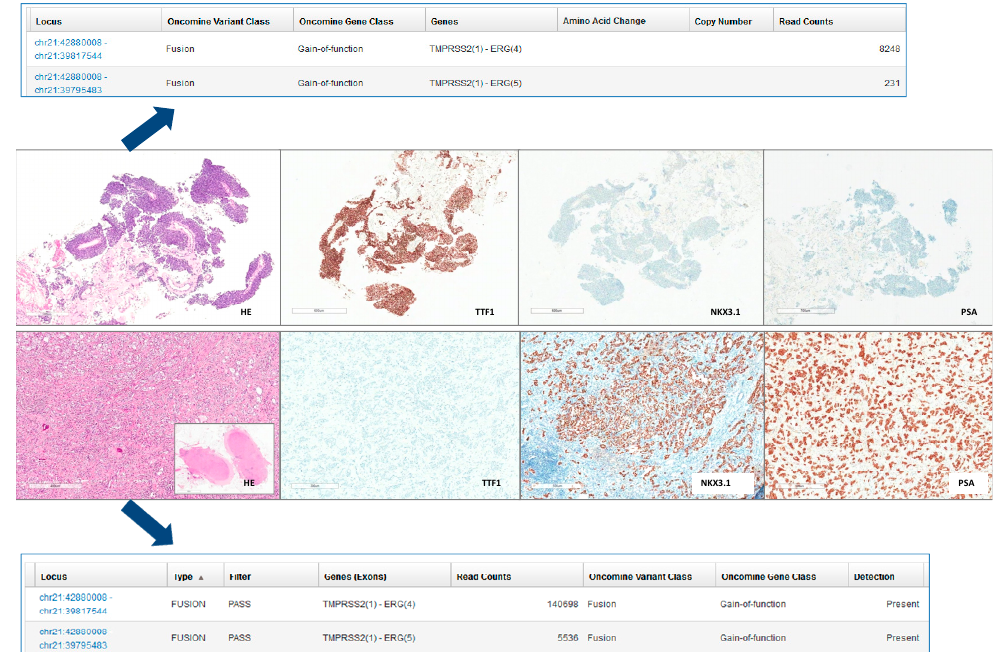
Figure 1. Histological, immunohistochemical, and NGS features of the lung ( top panel ) and prostate ( bottom panel ) lesions (100 × magnification for all histological images). Blue arrows indicate the genetic profile corresponding to the histological appearance. HE: hematoxylin and eosin; TTF-1: thyroid transcription factor-1; PSA: prostate-specific antigen.